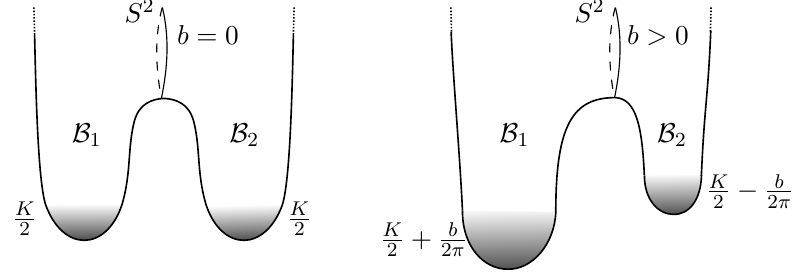
Figure 7 . The physical e(cid:11)ect of a (cid:12)eld excursion of the b -axion in the double throat system. One throat becomes shorter, whereas the other becomes